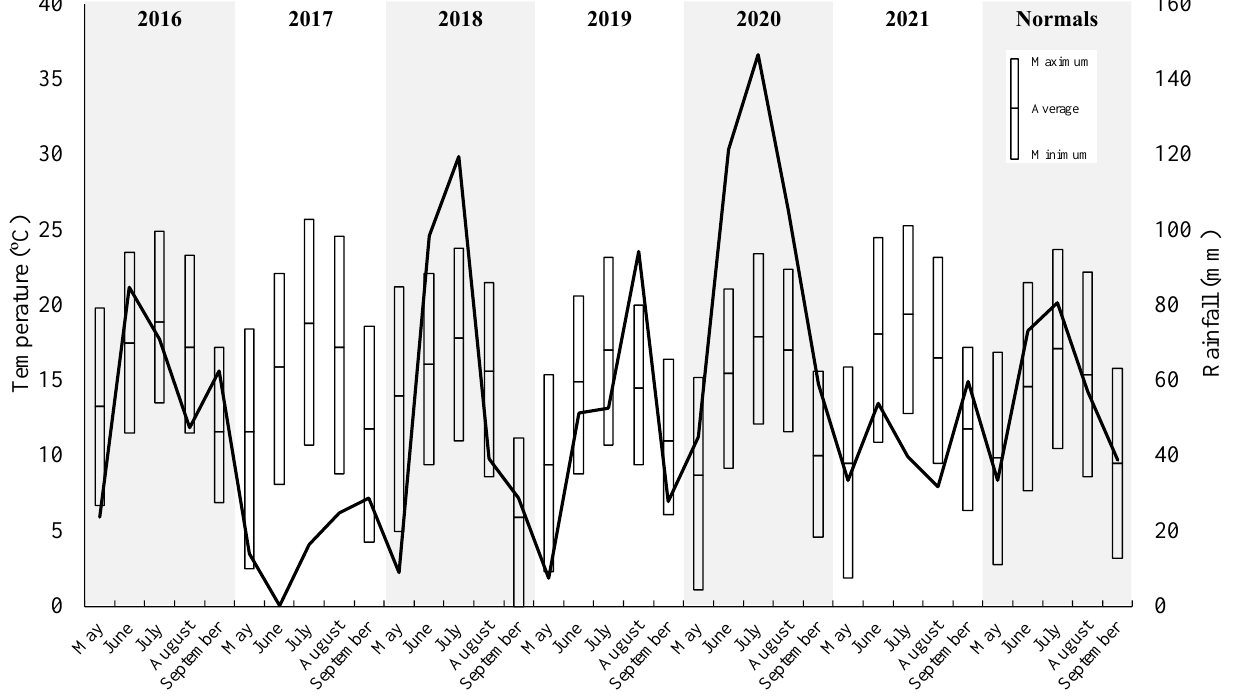
Figure 1. Average temperature range (bars; minimum, average, maximum; °C) and total rainfall (line; mm) for May – September 2016 – 2021 recorded at the Kearl Lake Weather Station. The 30-year climate normals (1981 – 2010) at the Fort McMurray station are shown (right).